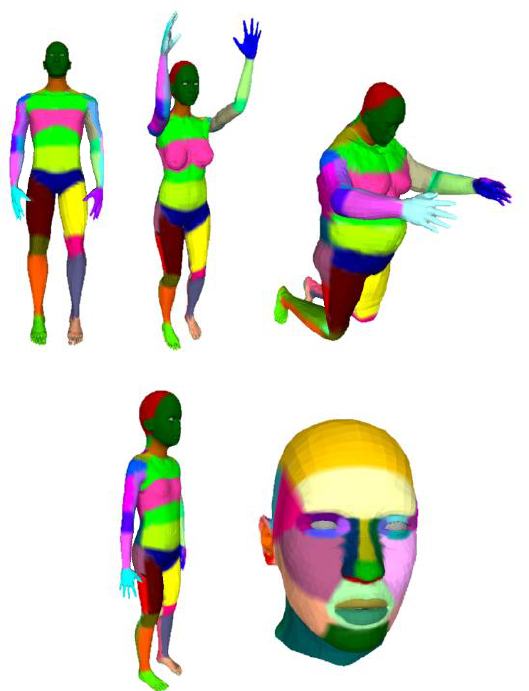
Figure 2. The five morphologies of SimUVEx: (on the top) adult man, adult woman, heavy man; (on the bottom) child, head-form. Each colour represents an anatomical